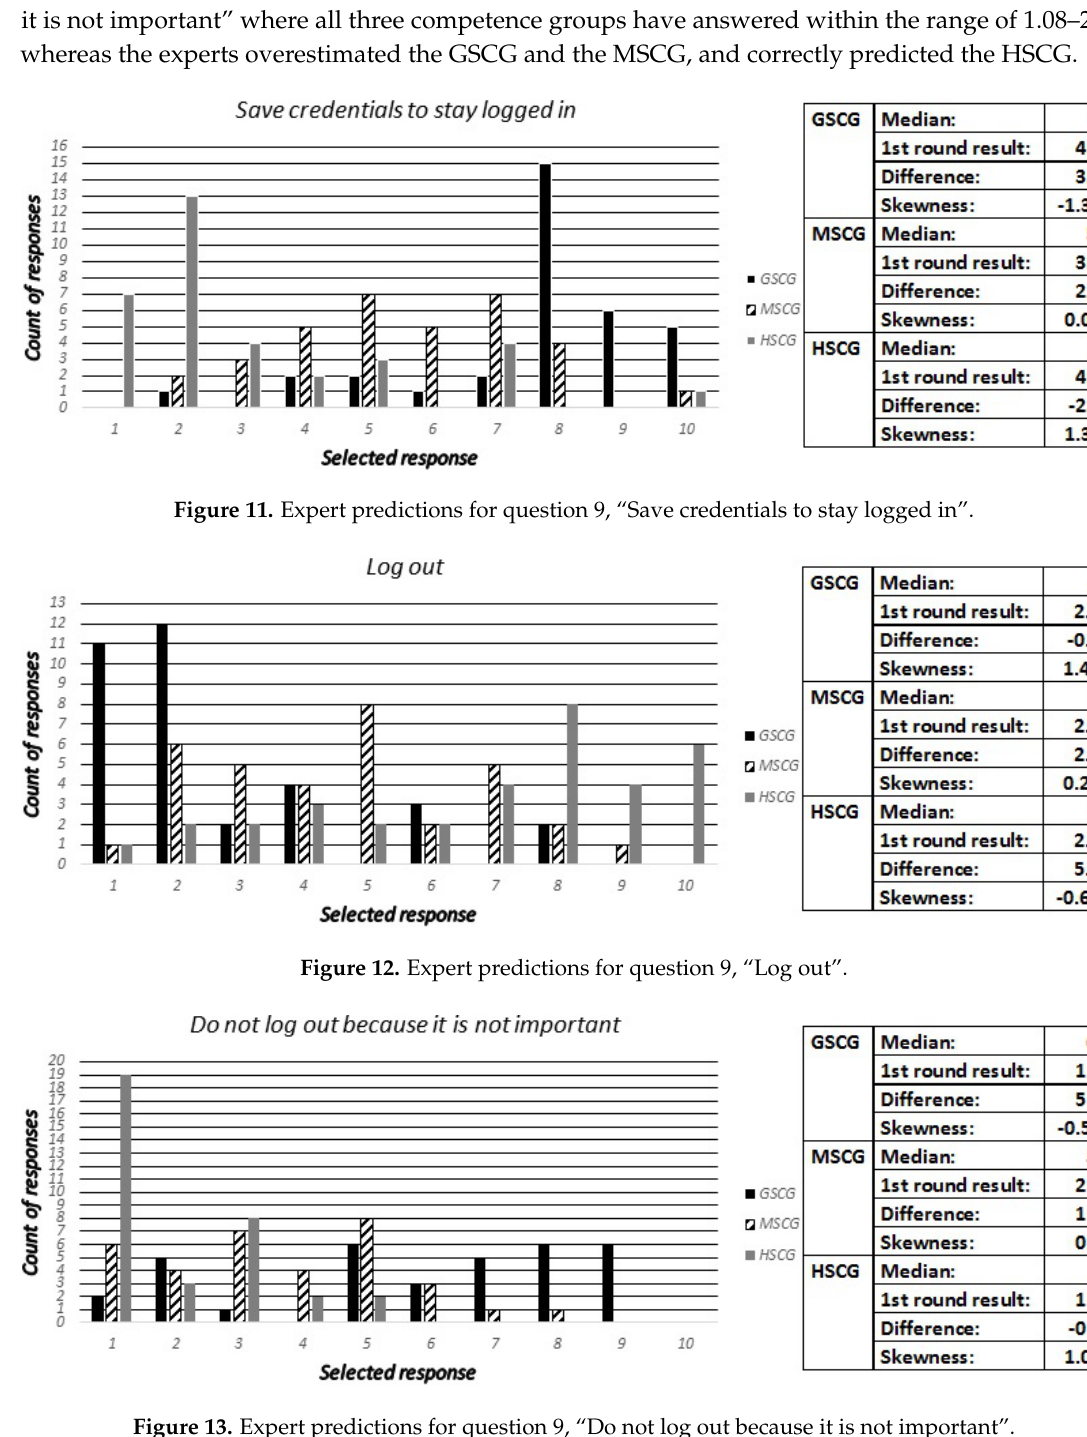
Figure 13. Expert predictions for question 9, “Do not log out because it is not